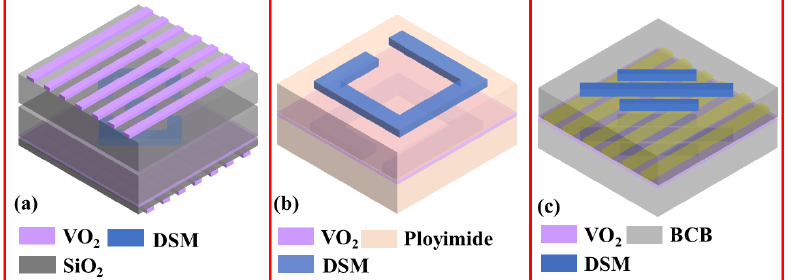
Figure 18. Multi-functional metamaterial structures based on the combination of VO 2 and DSM. ( a ) LTL and LTC polarization converter [176]; ( b ) asymmetric transmission and dual-directional absorption [177]; ( c ) polarization conversion and reflection device [178].